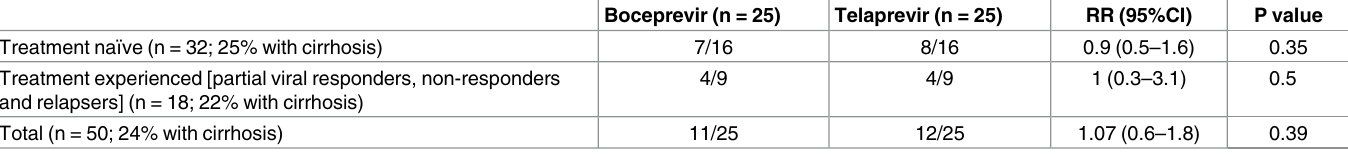
Table 3. SVR24 rates based on treatment exposure to boceprevir and